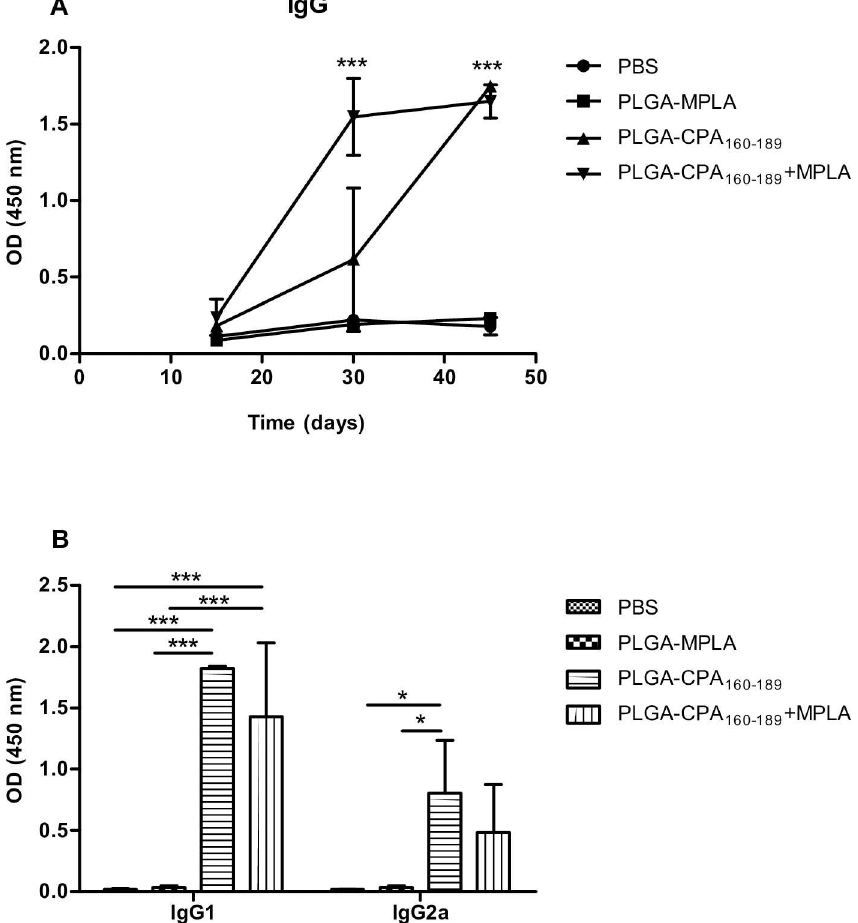
Fig 6. CPA 160-189 -specific humoral responses induction by PLGA NPs after vaccination. Detection of CPA 160-189 -specific (A) IgG, (B) IgG1 and IgG2a detectionin mice sera vaccinated with PLGA NPs at the indicatedtime points. Results are presented as means ± SD of five individualmice per group, representative of two independentexperiments with similar results. * p < 0.05, ** p < 0.01, *** p < 0.001for proliferation assay were assessedby two-way ANOVA and Bonferroni’s